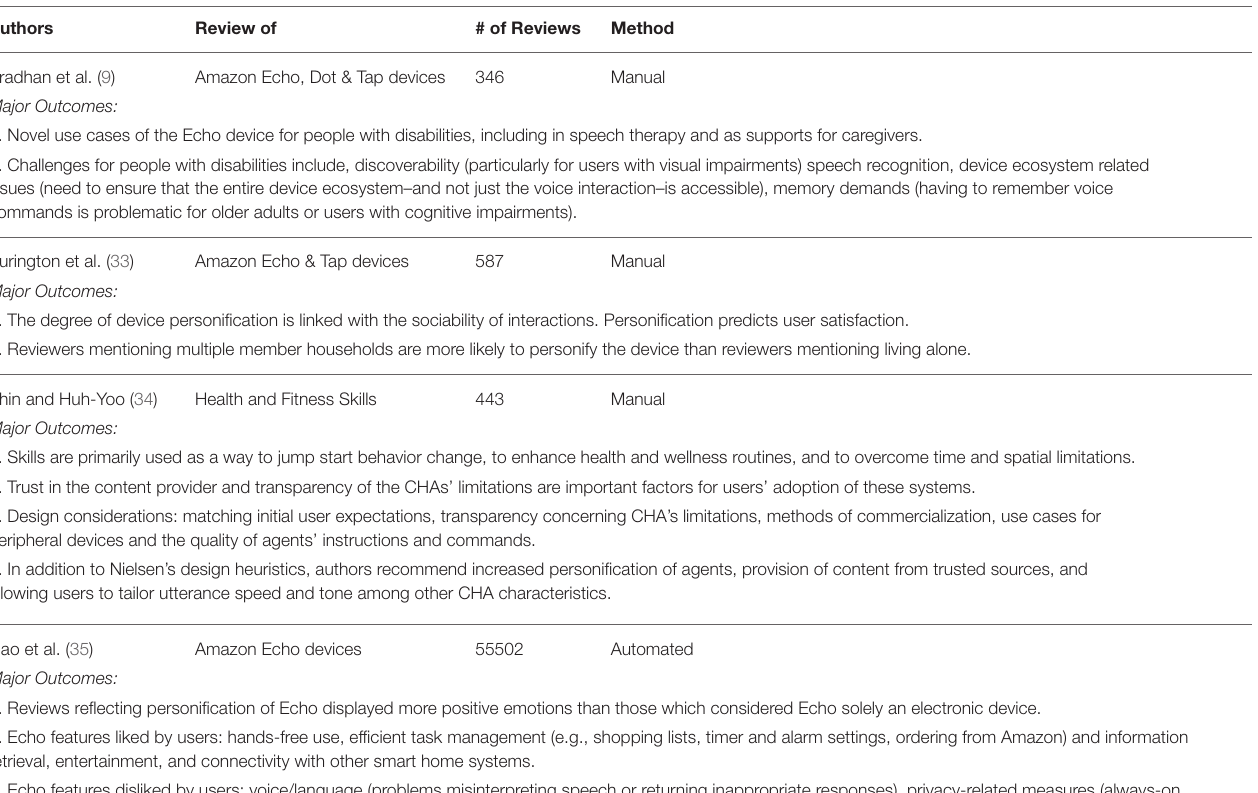
TABLE 1 | Summary of the results from prior related work analyzing reviews of Alexa health and fitness skills and Alexa